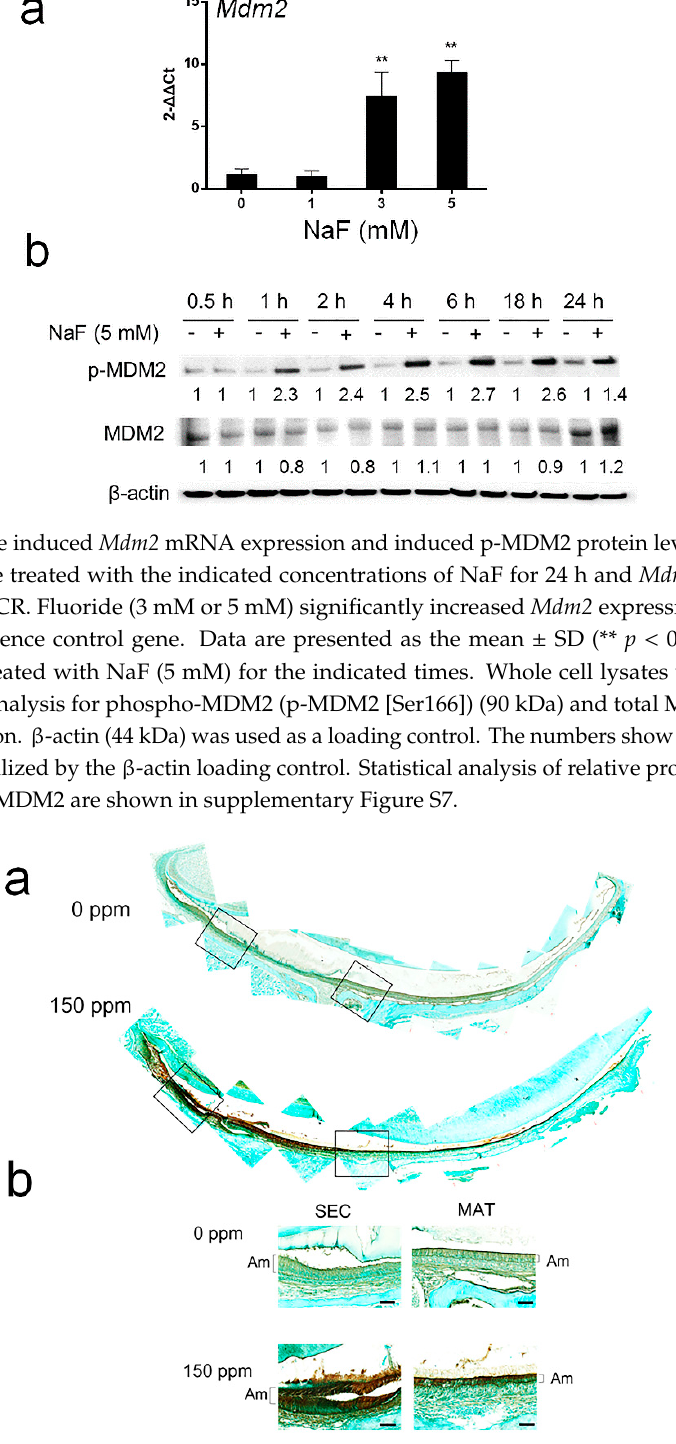
Figure 5. Fluoride increased p-MDM2 protein expression in mouse ameloblasts. Mice were treated with 0 or 150 ppm fluoride in drinking water for 6 weeks. ( a ) p-MDM2 [Ser185] was detected by immunohistochemistry in maxillary incisors from mice treated with 0 ppm (upper panel) or 150 ppm (lower panel) fluoride. ( b ) High magnification of p-MDM2 staining in secretory stage (SEC) and maturation stage (MAT) mouse enamel organs. More p-MDM2 was formed in mouse ameloblasts treated with 150 ppm fluoride compared to control ameloblasts (0 ppm). Shown are representative images from three mice. Scale bar represents 20 μ m. Brackets denote ameloblasts (Am).